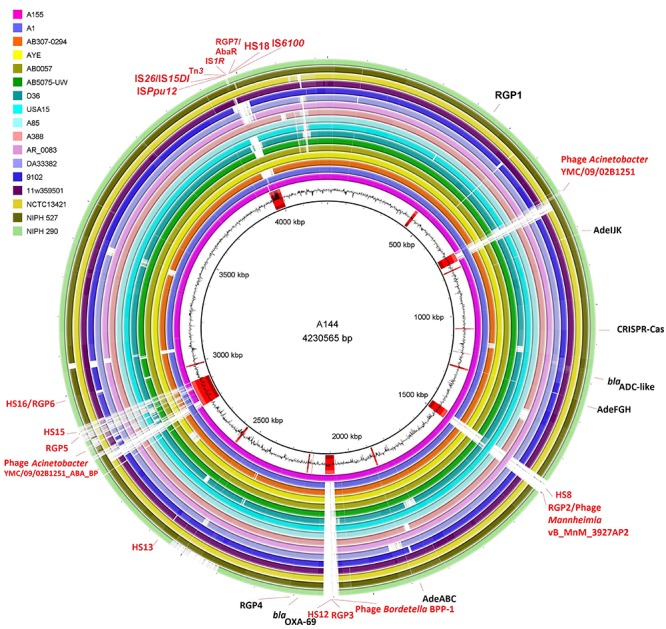
Prediction of elements of the accessory genomes identified in GC1 Group 1 genomes from this study. Genetic and physical map of GC1 chromosomes. The inner black circle belongs to A144 chromosome and the inset legend indicates the remaining GC1 Group1 chromosomes. The outer legend corresponds to RGP, bla genes, the three efflux pumps and CRIPSR/Cas found in the eighteen GC1 Group 1 genomes in the same loci, indicated with black letters and lines is also shown in the outer circle. The hot spots (HS), RGP, and prophages found in A144 are shown in red letters and lines. Black histogram represents CG content of A144 strain. Regions related to some hotspots (HS) disrupted synteny among GC1 chromosomes which also corresponded to RGP in A144 as follows, RGP2/HS8 (JQSF01000083.1: 1-33700 and JQSF01000082.1: 24920-27366), RGP3/HS12 (JQSF01000043.1: 1 -38248 and JQSF01000071.1: 12398-14538), RGP5/HS15 together with RGP6/HS16 (JQSF01000080.1: 153-15902, JQSF01000022.1, JQSF01000055.1, JQSF01000037.1, JQSF01000003.1, QSF01000040.1, JQSF01000042.1, JQSF01000065.1 and JQSF01000041.1: 1-20291), and RGP7/HS18 that corresponded to AbaR GI (JQSF01000053.1: 1-8092, JQSF01000058.1, JQSF01000063.1: 797-1612, JQSF01000054.1: 253-2358, JQSF01000030.1: 448-21672, and JQSF01000084.1: 23-13490).